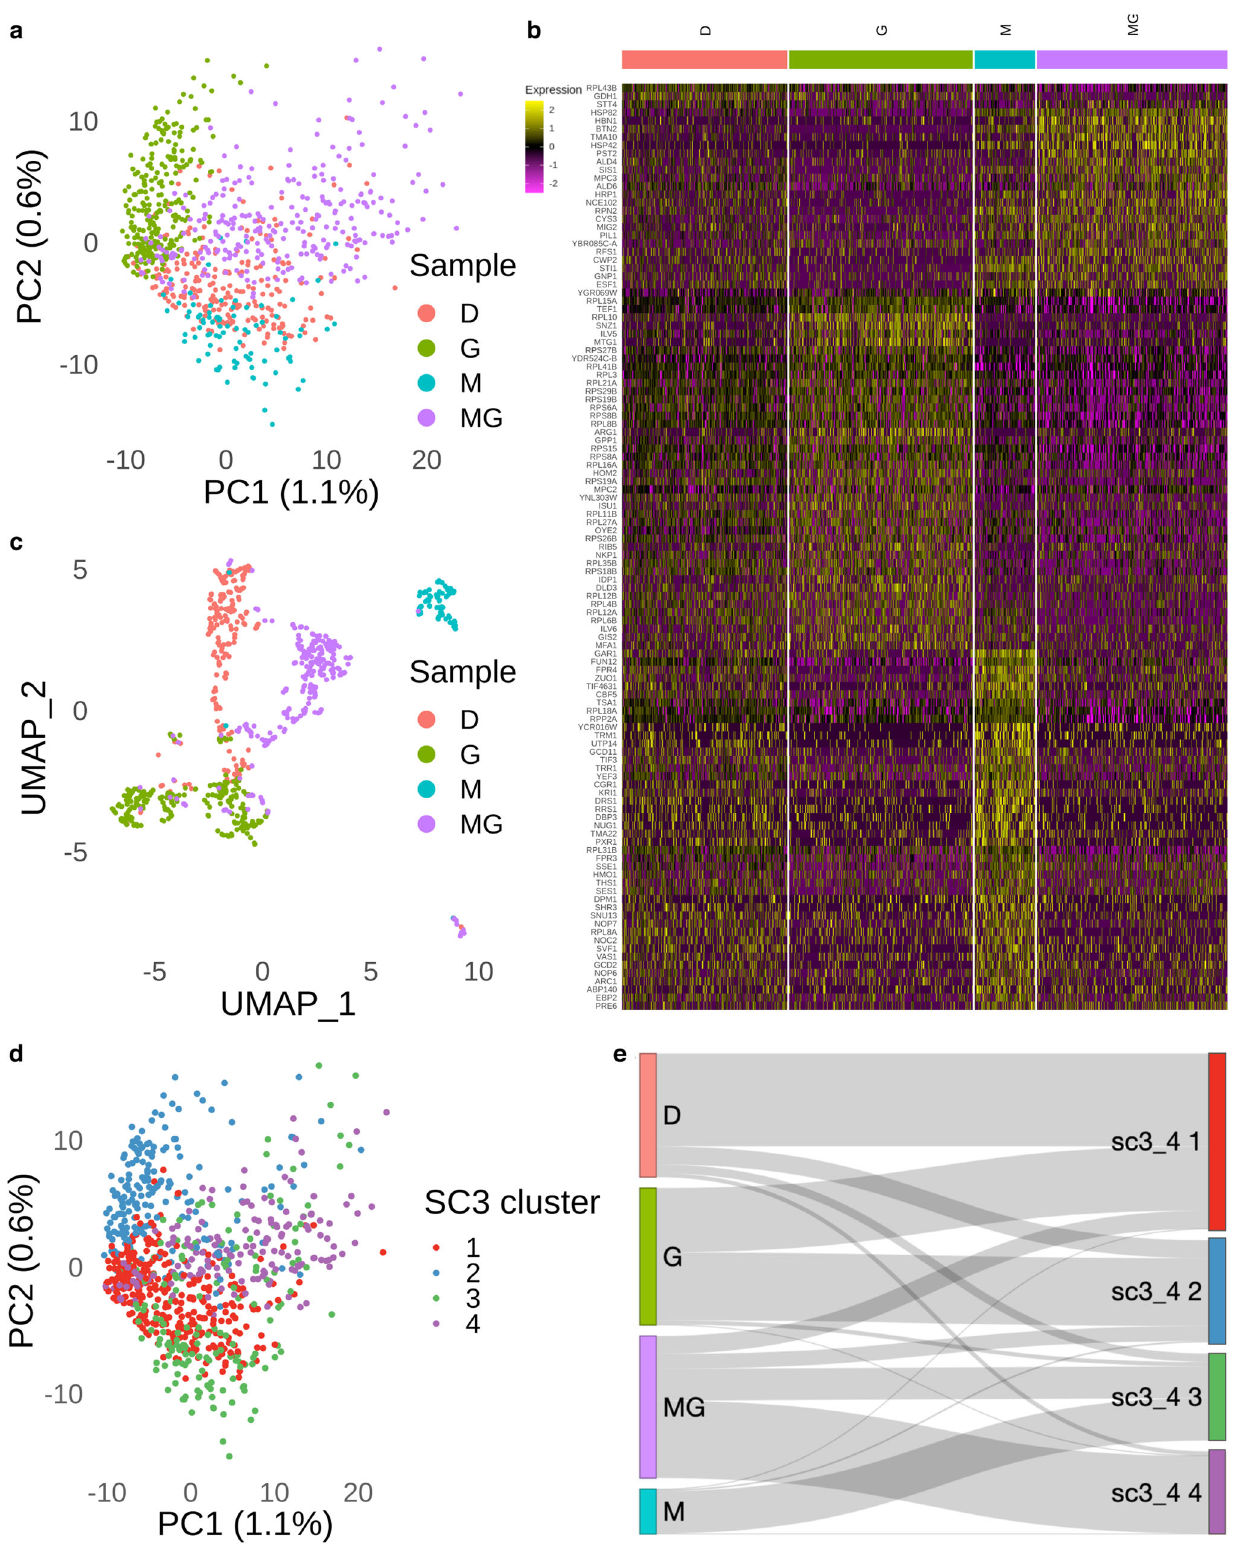
Fig. 2 Identi fi cation of DE genes in the 4 samples. a PCA plot illustrating the distribution of the 4 samples (D n = 233, G n = 258, M n = 85, MG n = 268 cells). b Heatmap illustrating the DE genes corresponding to the 4 samples (Supplementary Data 3). The color represents the normalized expression level in natural-log scale of the corresponding genes of a cell (yellow is high). c UMAP plot of the 4 samples (D n = 233, G n = 258, M n = 85, MG n = 268 cells) based on the PC spaces in panel a . d Semi-supervised clustering identi fi es 4 clusters across the 4 samples. e Sankey plot illustrating the 4 samples mapping to the 4 SC3 clusters (cluster 1 n = 331, cluster 2 n = 193, cluster 3 n = 164, cluster 4 n = 156 cells). DE genes means differentially expressed